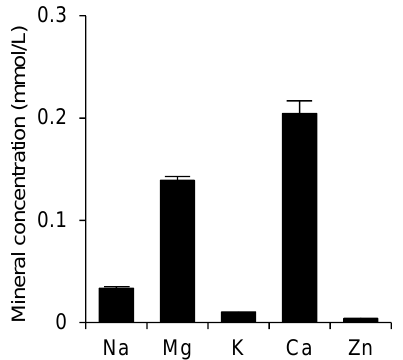
Figure 1. Mineral concentration of Shotokuseki extract. The mineral concentrations were analyzed by atomic absorption spectroscopy. Data are expressed as mean ± S.D. of three to six independent experiments.